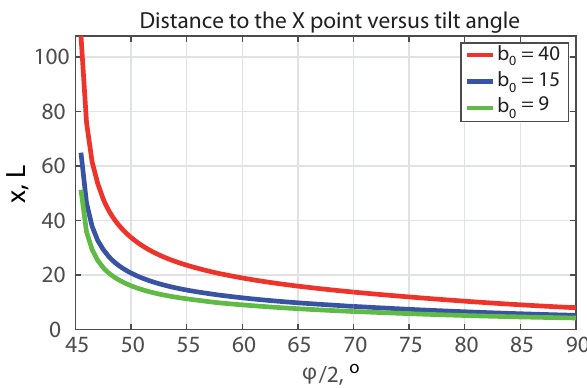
Figure 2. X-point location vs. the effective tilt angle ϕ/ 2 in the asymmetric Kan solution (Eqs. 7–9) with a = 0 and parameters b 0 = 40 (red), b 0 = 15 (blue), and b 0 = 9 (green).